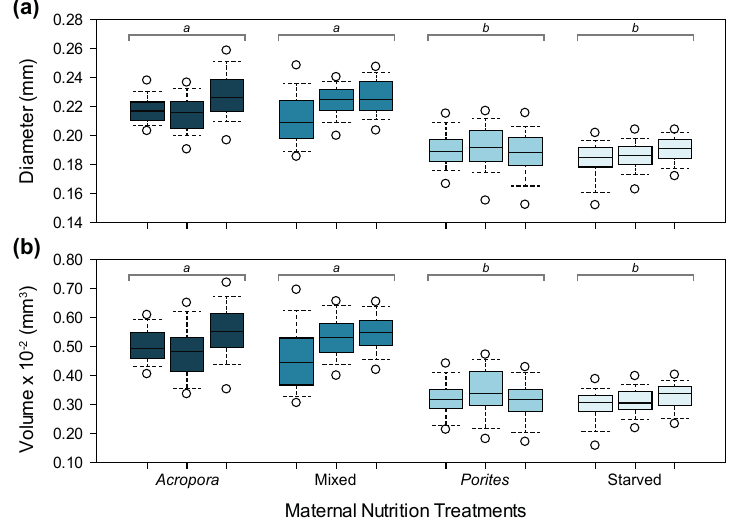
Figure 2. Size of oocytes from female starfish under different maternal nutrition treatments: ( a ) oocyte diameter; ( b ) oocyte volume. Boxplots with different letters above are significantly different.